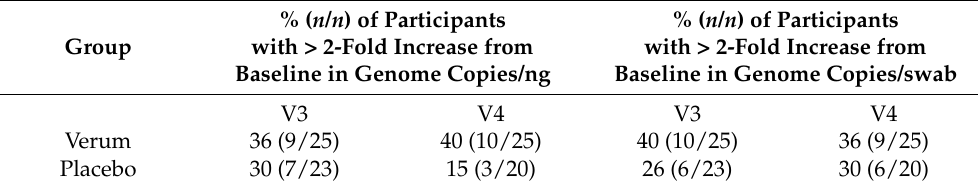
Table 6. Percentage of participants with an over 2-fold increase from baseline in lactobacilli copies per ng of DNA or swab. The analysis applied Lactobacillus acidophilus primers designed by Song et al., 2000, with Lactobacillus crispatus DSM 20,584 used as the standard. V, Visit; V3, after one week of intervention; V4, after two weeks of intervention.